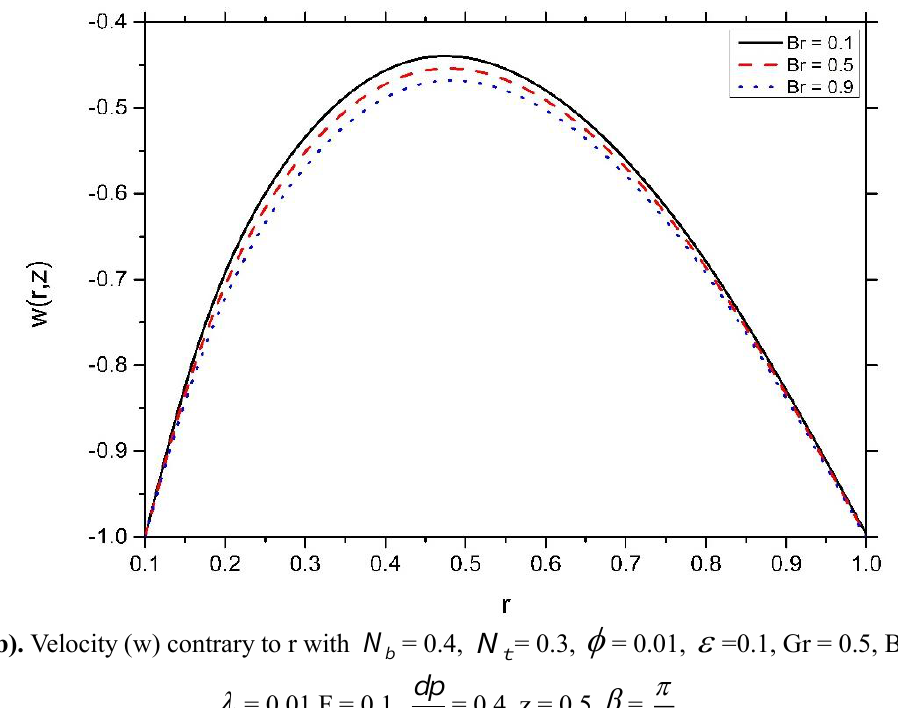
Fig. 3(b). Velocity (w) contrary to r with